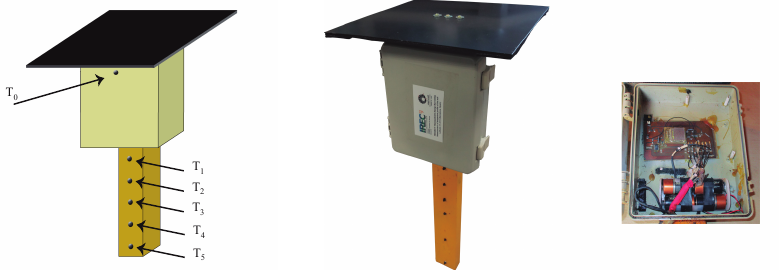
Figure 2. Sketch and photograph of the flat panel with temperature sensor and